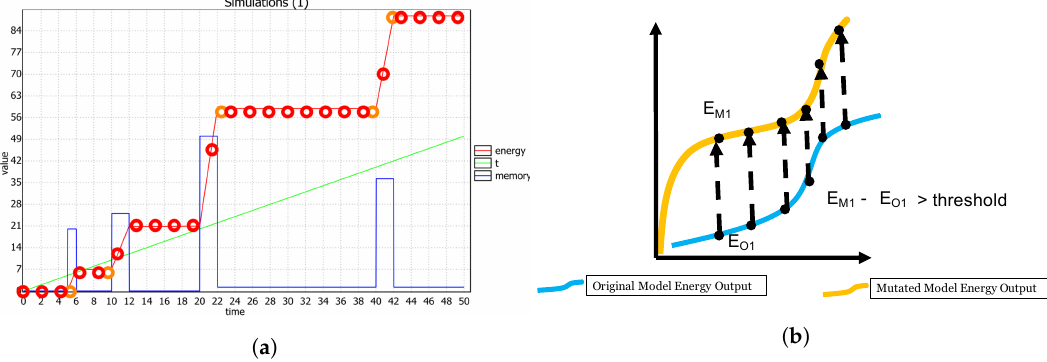
Figure 4. Test Generation and mutant detection for energy consumption. ( a ) An example of a sampled simulation trace obtained from UPPAAL SMC. ( b ) An example of applying mutation detection on two traces based on a predefined